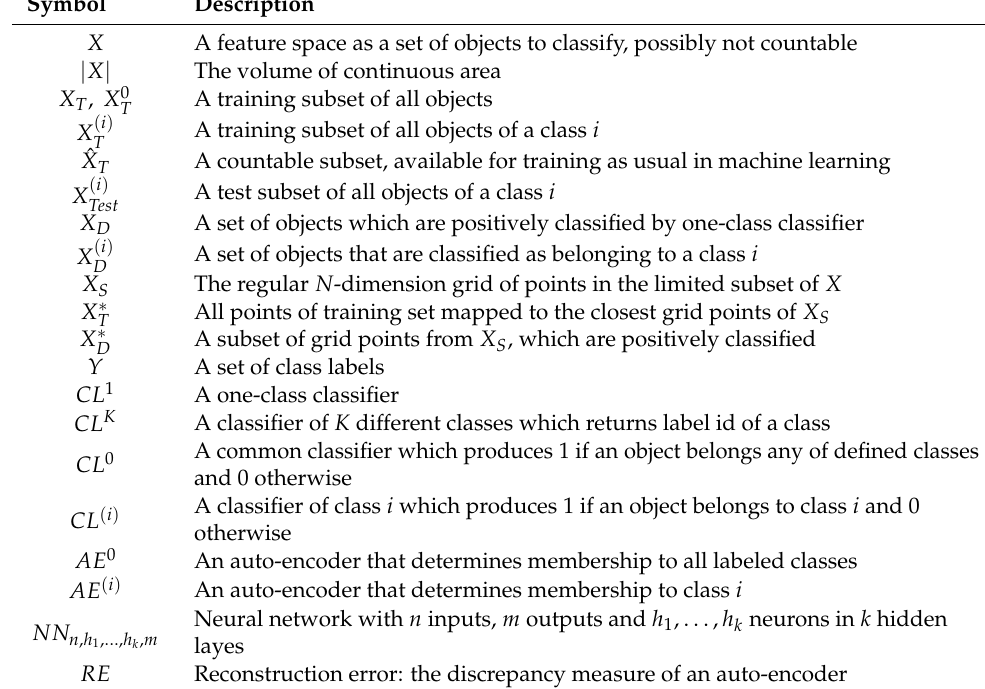
(Table 2): True Positive ( TP ), True Negative ( TN ), False Positive ( FP ), False Negative ( FN